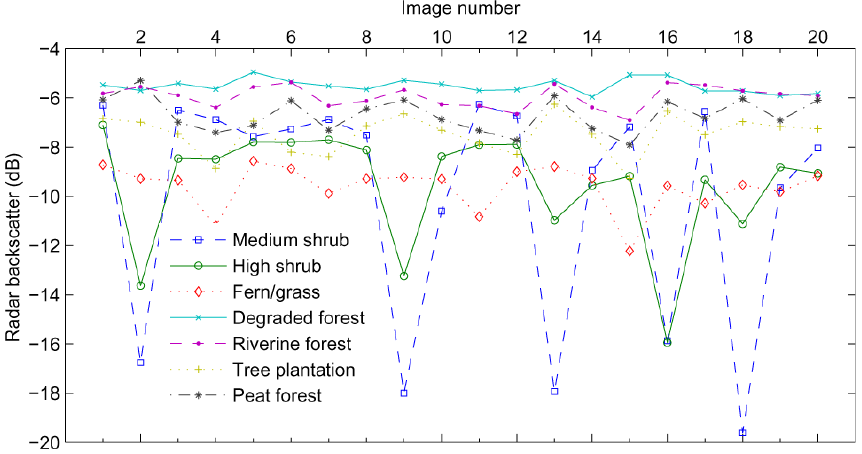
Fig. 6. Radar backscatter mean values of land cover classes in the Mahakam lakes area. Image numbers correspond with image acquisition dates in Table 1.